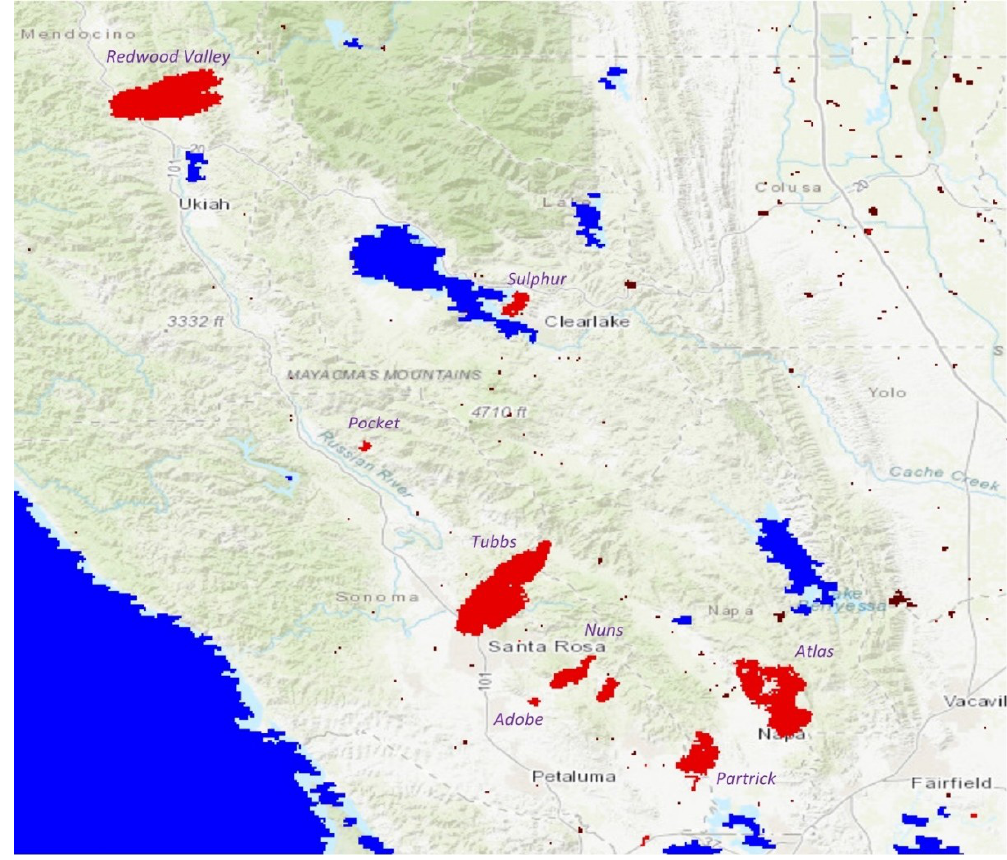
Figure 1. 8–9 October 2017 wildfires. Satellite active fire detections revealed by the Suomi National Polar-orbiting Partnership Visible Infrared Imaging Radiometer Suite (S-NPP/VIIRS) at 3:09 A.M. Fire names are shown in purple italics.